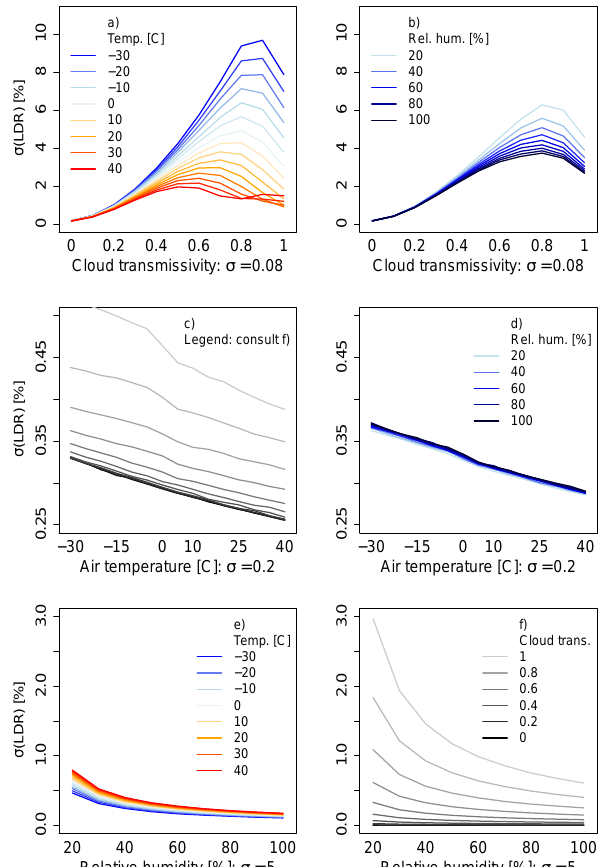
Fig. 10. LDR sensitivity to errors in estimated cloud transmissiv- ity ( σ = 0 . 08, (a) and (b) ), measured air temperature ( σ = 0 . 2 ◦ C, (c) and (d) ) and relative humidity ( σ = 5%, (e) and (f) ). LDR sen- sitivity is expressed in the relative standard deviation of the simu- lated LDR using Monte Carlo. For air temperature for example, a mean value of 5 ◦ C with an uncertainty of 0.2 ◦ C results in a relative standard deviation of 0.45% for clear-skies ( τ c = 1) and 0.3% for overcast